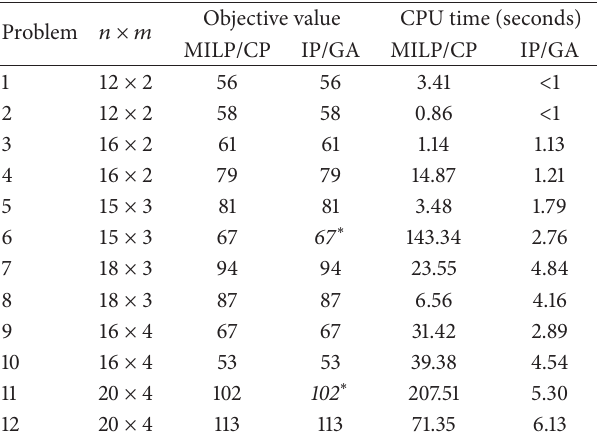
Table 2: Experimental result for the small sized